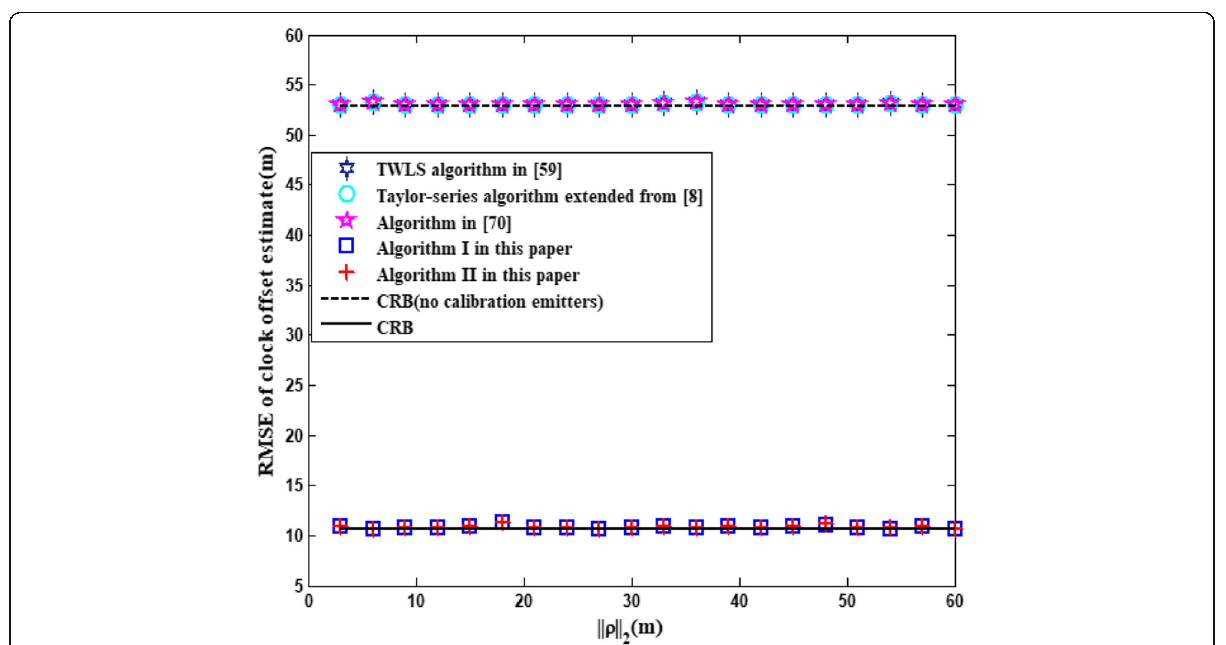
Fig. 14 RMSE of clock offset estimate versus ‖ ρ ‖